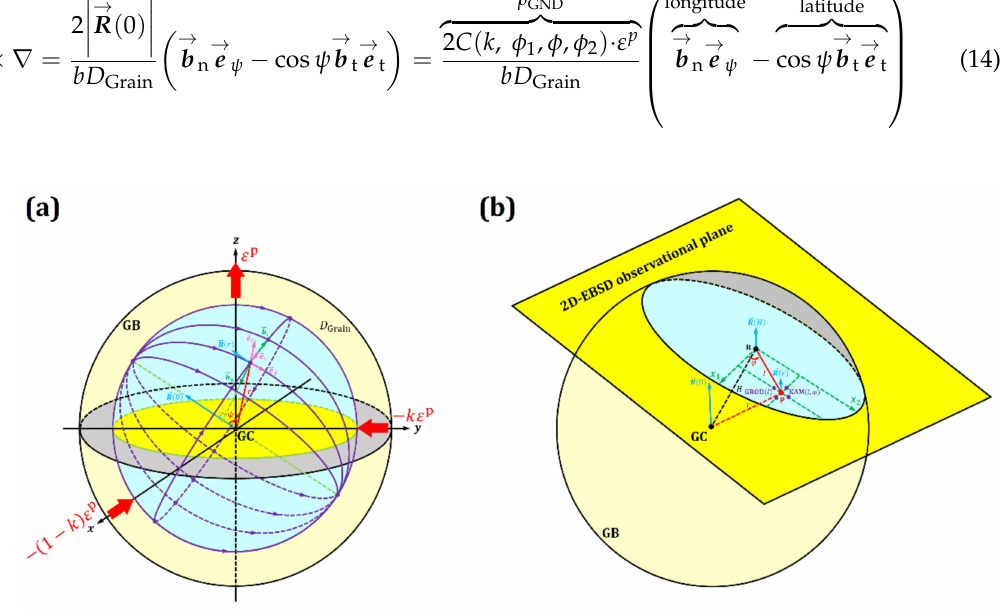
→ R ( r ) and geometrically necessary dislocation ρ GND ( ψ ) , Figure 12. ( a ) Intragranular misorientation as well as ( b ) KAM and GROD values measured on arbitrary 2D-EBSD observational